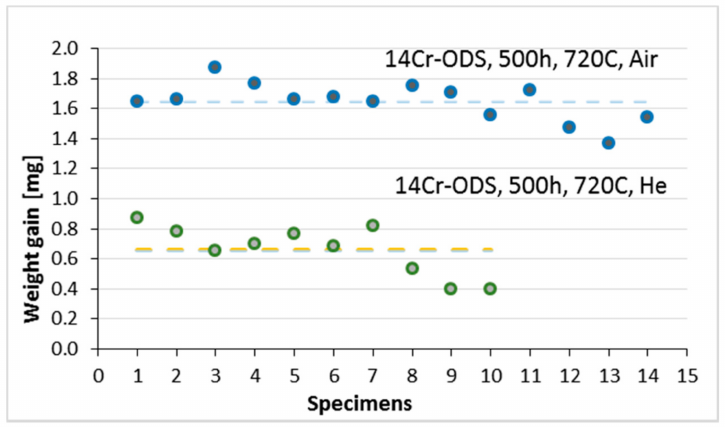
Figure 9. Specimen weight gain after exposure for 500 h at 720 ◦ C in air (blue dots) and helium (green dots). The dotted lines highlight the average value.